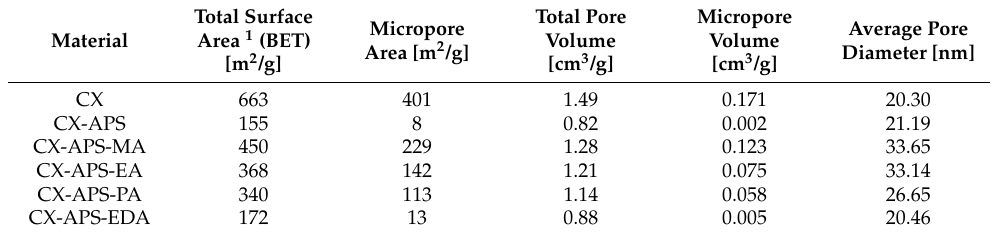
Table 2. Textural properties of the samples